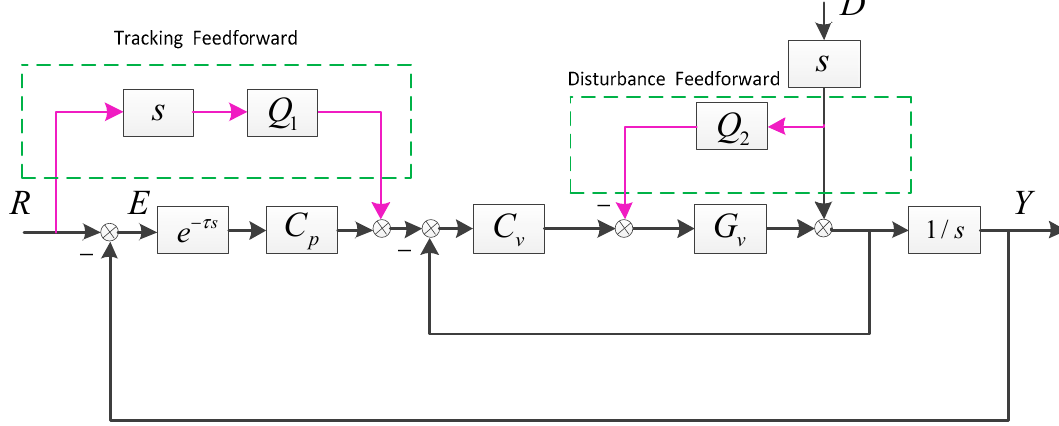
Figure 3. The direct feedforward structure based on VPDC.